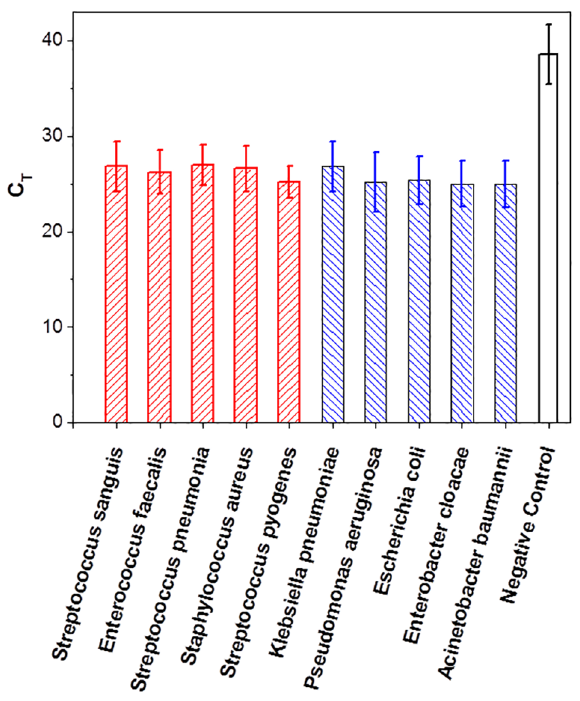
Figure 15. The electrical lysis efficiency of a polymicrobial sample. The performance of the electric lysis device for lysing a polymicrobial sample was demonstrated by lysing a cell suspension containing Gram-negative bacteria E. coli and Gram-positive bacteria S. pneumoniae cells and determining the amount of released ribosomal RNA from RT-PCR assay performed on the cell lysate.